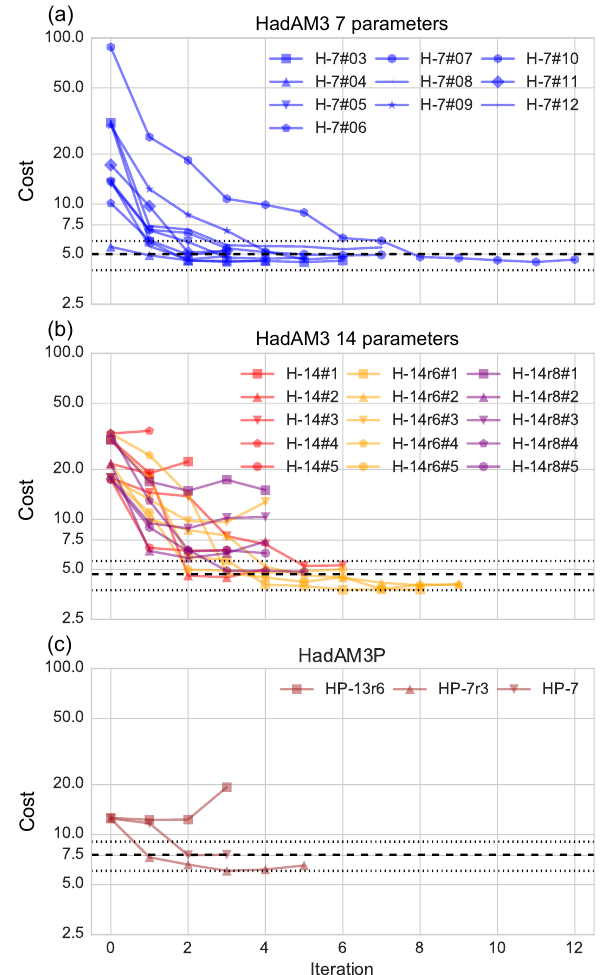
Figure 1. Minimum cost function for line-search component of algorithm ( y axis) vs. iteration number ( x axis) for HadAM3 7- parameter (a) , HadAM3 14-parameter (b) and HadAM3P (c) op- timisations. Iteration 0 is the cost function for the initial param- eter values. The y axis uses a logarithmic scale. In each subplot the dashed black line shows the cost function for the standard model while the dotted lines show the ± 20% ranges on this, show- ing perturbed models comparable with the standard configuration. Coloured lines and symbols use the key shown in each subplot. For plots (b, c) labels with rP rand had P rand random parameters per- turbed on each iteration.